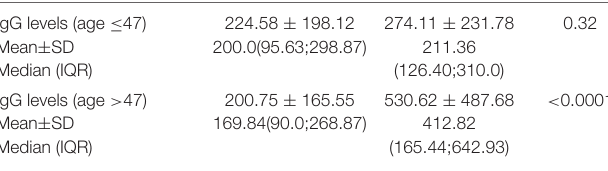
TABLE 2 | Comparison of IgG levels in subjects previously infected or naive by age younger or older than 47